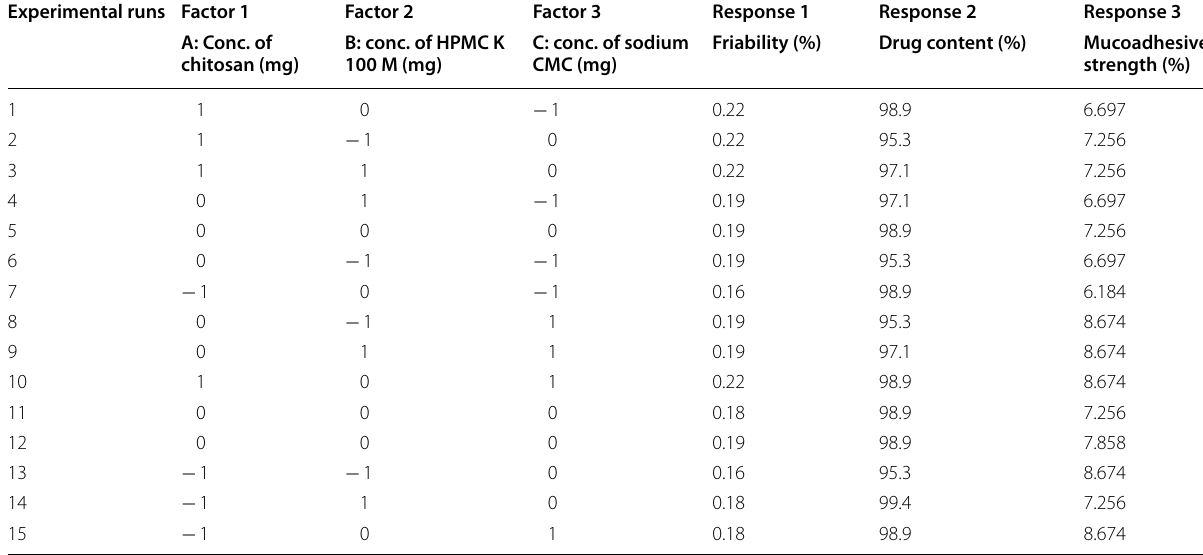
Table 2 Design matrix of cefuroxime axetil mucoadhesive minitablets by employing Box–Behnken design Experimental runs Factor